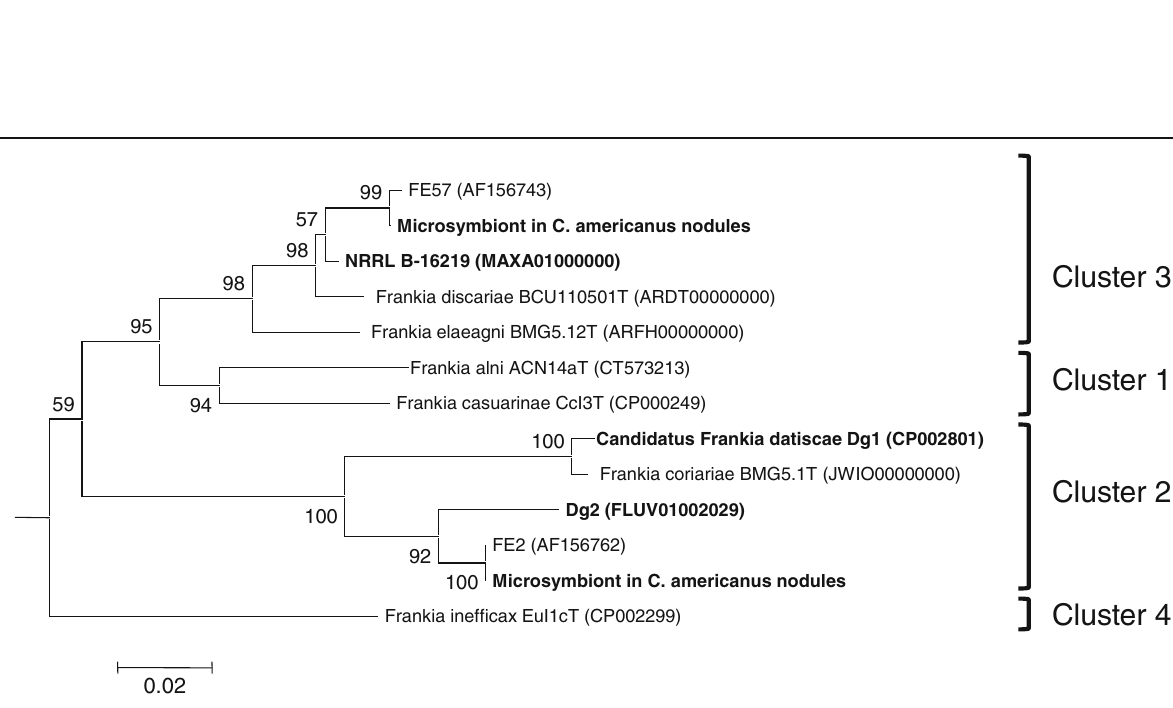
Fig. 5 Neighbor-Joining phylogenetic tree based on gln A gene sequences. Bootstrap and probability values larger than 50% are only shown. Marked in bold are Frankia strains or microsymbionts with nod genes as present in their genomes or detected by PCR-sequencing analysis